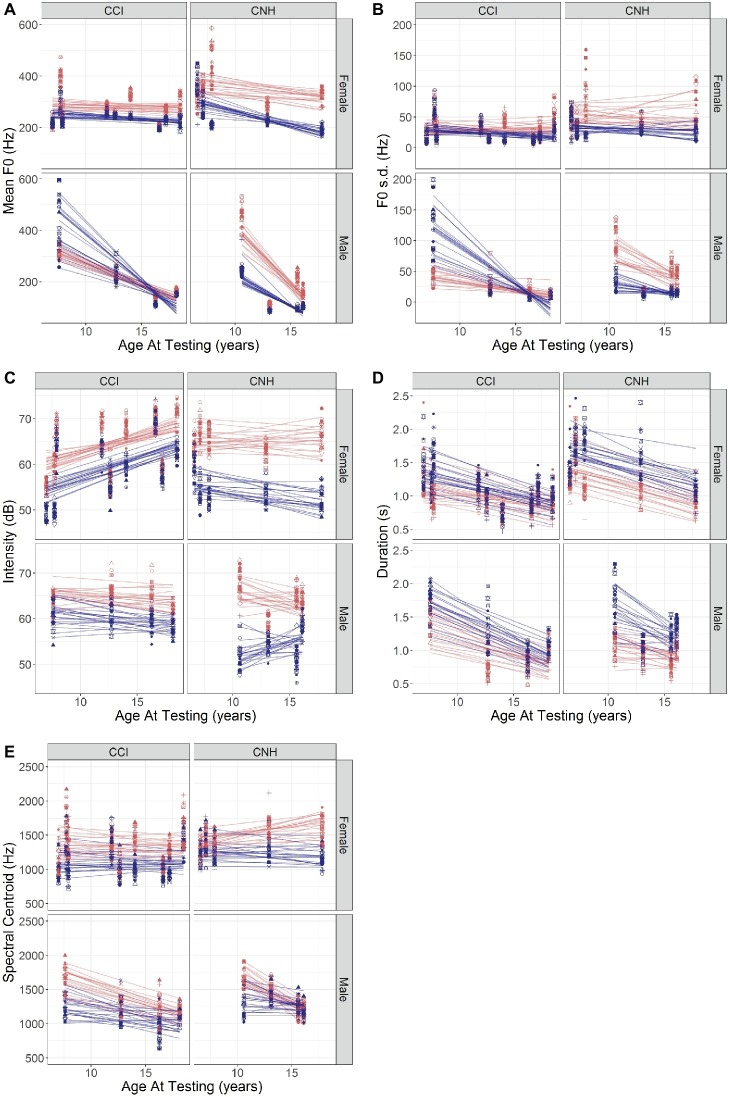
(A–E) Values of acoustic features (A: mean F0; B: F0 s.d.; C: Intensity; D: Duration; E: Spectral Centroid) of the happy (red) and sad (blue) emotions recorded by CNH and CCI, plotted against their age (abscissa). For each acoustic feature, left- and right-hand panels show results in CCI and CNH, respectively, and upper and lower plots show results in female and male participants, respectively. The differently shaped symbols and lines in each color represent individual sentences recorded in each emotion.